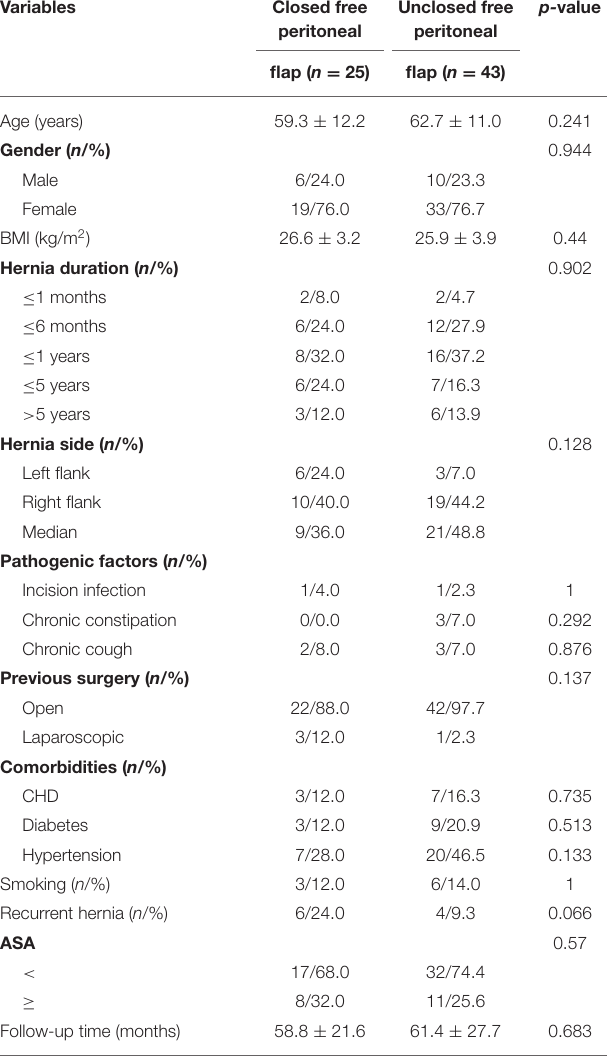
TABLE 4 | Comparison of demographics, comorbidities and hernia characteristics of patients in two groups.